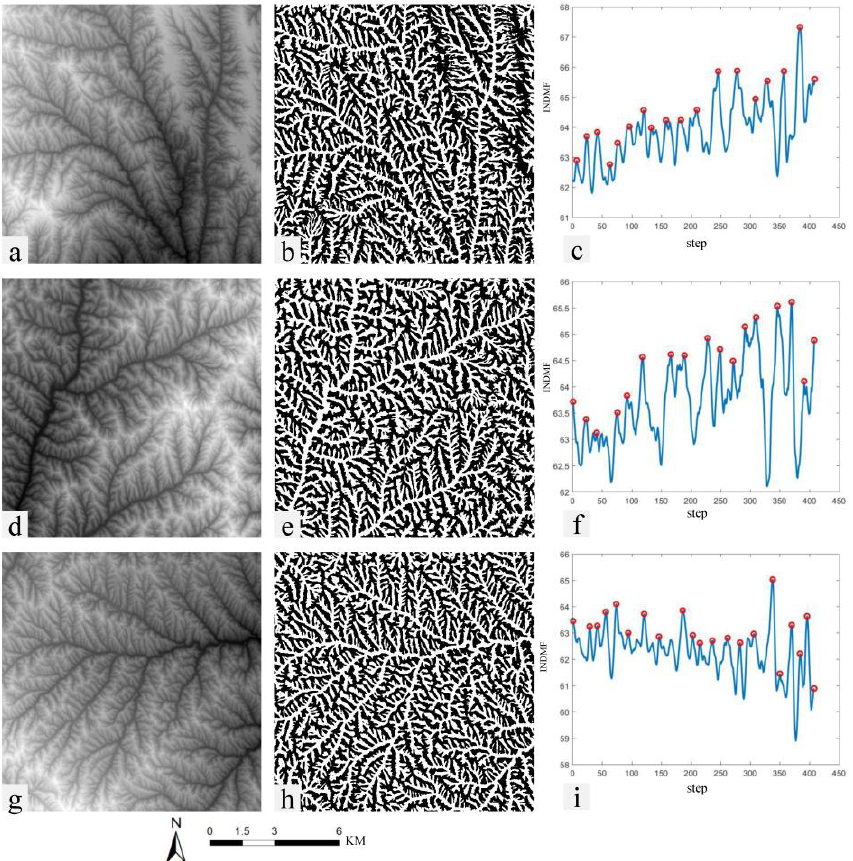
Figure 6. INDMF regularity based on loess hill areas. ( a ) sample 1; ( b ) positive and negative terrains